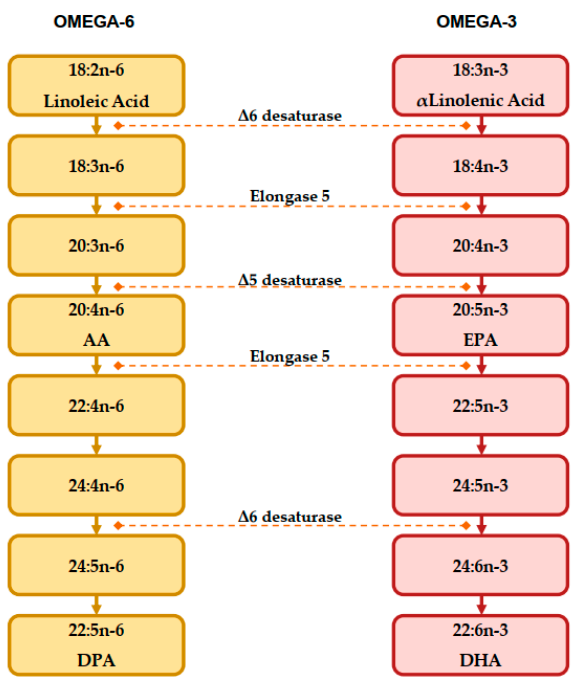
Figure 2. Biosynthesis pathway of LCPUFAs from precursors, adapted from Patterson et al. [12].